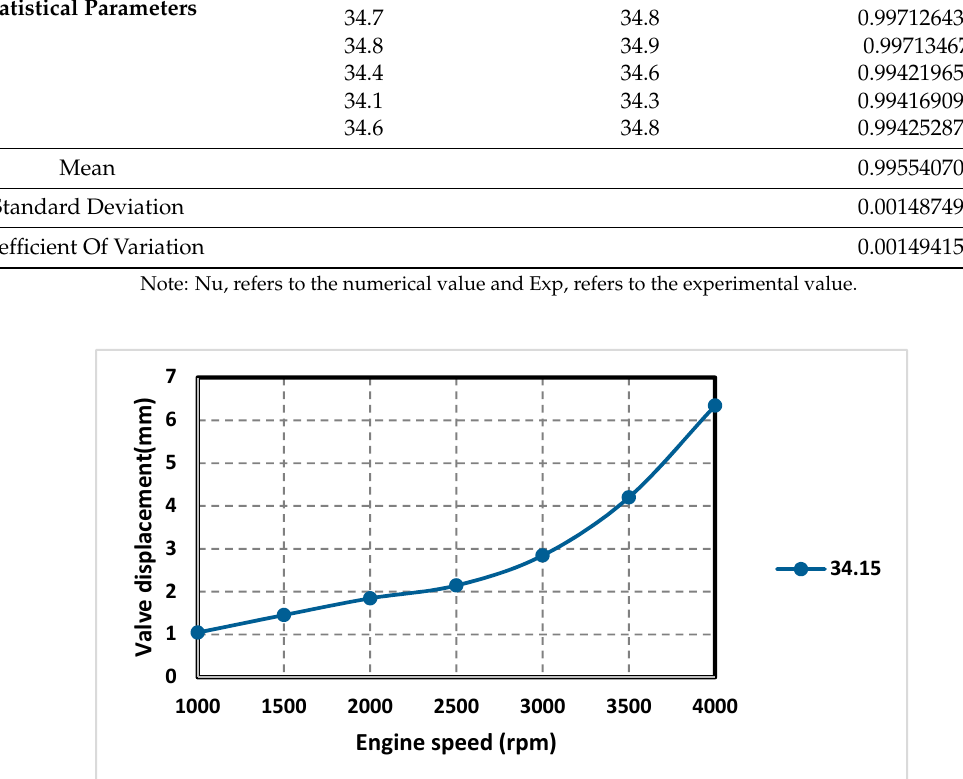
Figure 21. Comparison between the experimental and numerical results for air-CNG ratio inside the new mixer.